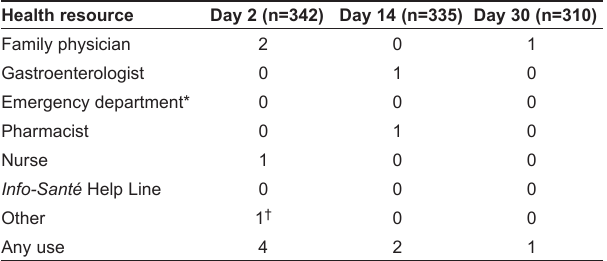
TAblE 4 Number of individuals who used health resources for minor adverse events according to assessment time point